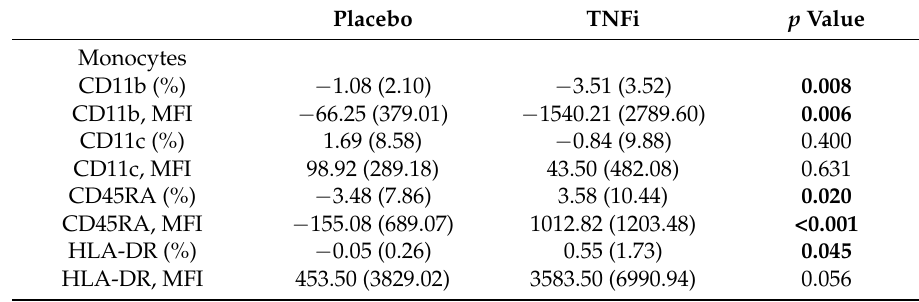
Table 3. Expression of activation markers on monocytes and their subpopulation shown as a delta t2 −